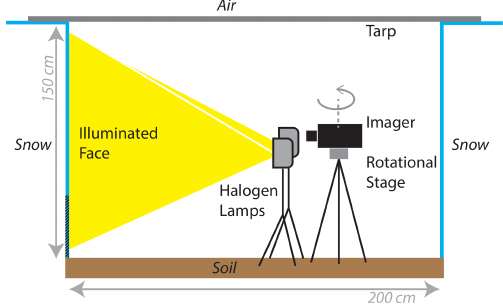
Figure 5. Schematic of the near-infrared hyperspectral imaging setup in the field for measurement of liquid water content across a snowpit wall. The area at the bottom 40cm of the snowpit was not imaged and is shown with hatched lines. Figure 6. Simulated bidirectional reflectance of snow using three